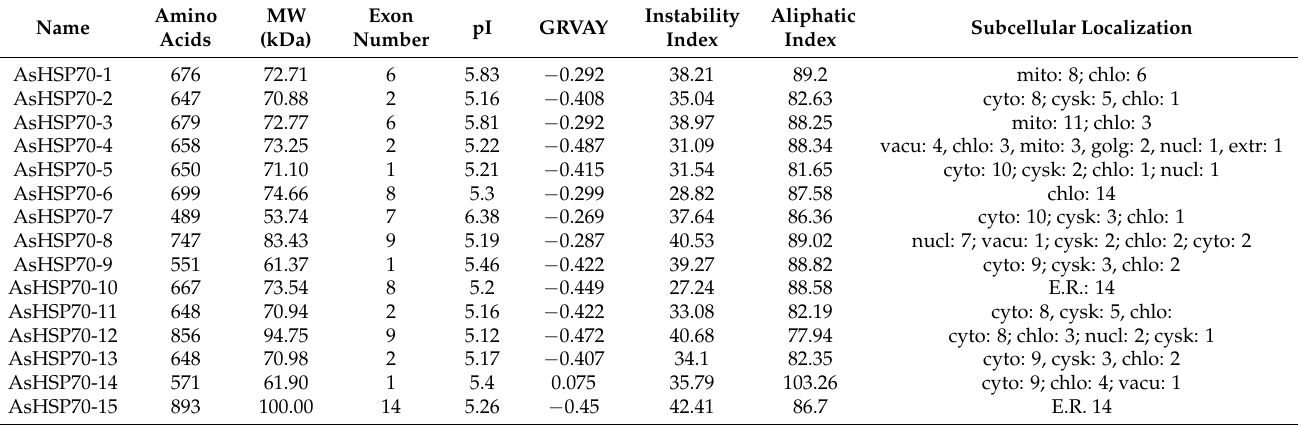
Table 1. Summary information of predicted physiological and biochemical properties of the AsHSP70 proteins based on the ExPASy